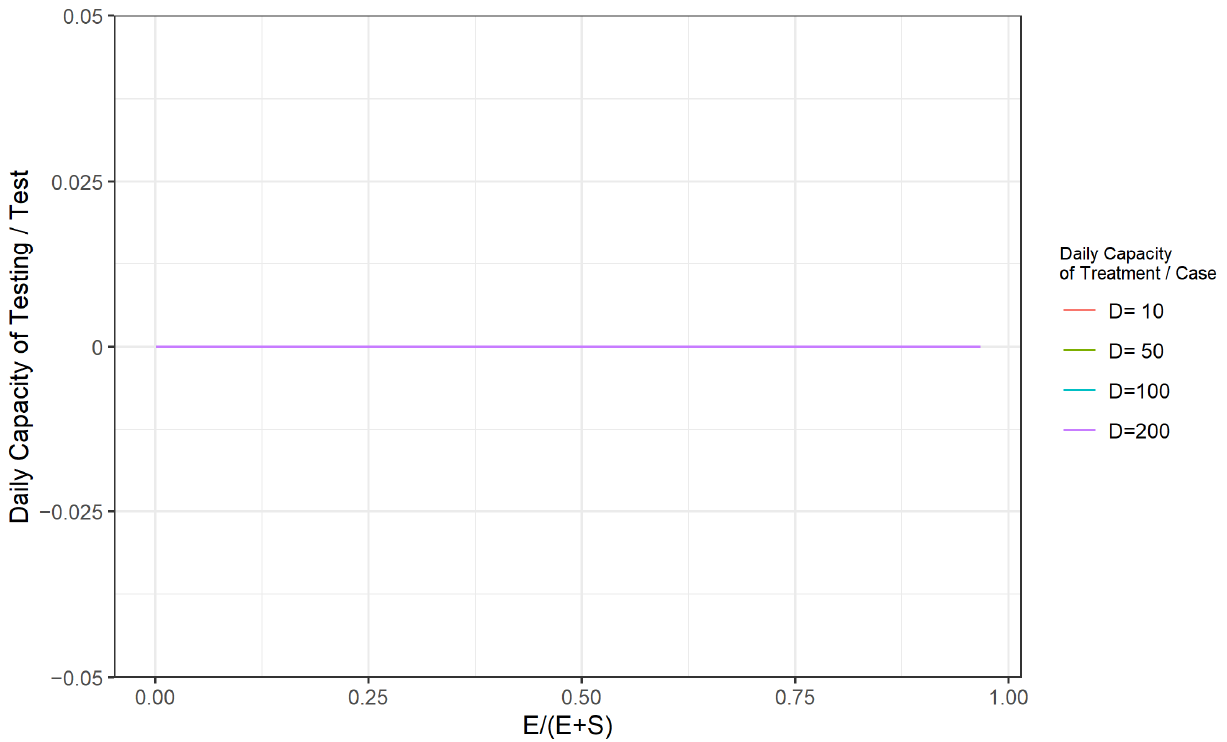
Figure A16. Relationship between the daily testing capacity of the epidemic and the potential level of the epidemic development ( S + E = 5000, I = 1000).